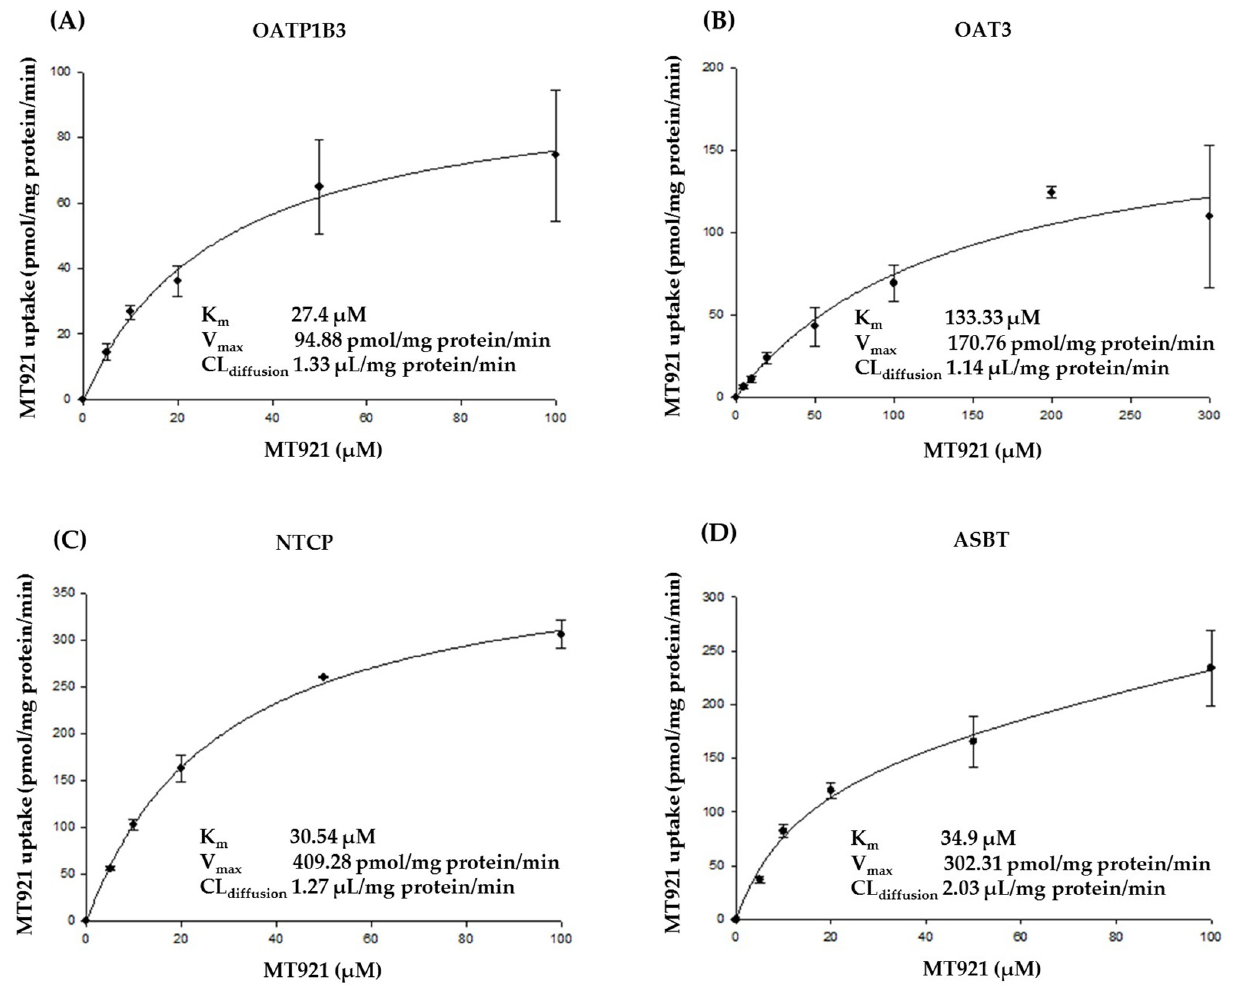
Figure 1. Concentration-dependent uptake of MT921 (5–100 µM for OATP1B3, NTCP, and ASBT, 5–300 µM for OAT3) in HEK 293 ( A ) -OATP1B3; ( B ) -OAT3; ( C ) -NTCP; ( D ) -ASBT. Each bar represents mean ± standard deviation from triplicate experiments. V max , maximum velocity at saturating substrate concentration; [S], substrate concentration; K m , substrate concentration at half of V max ; CL diffusion represents the passive diffusion clearance.